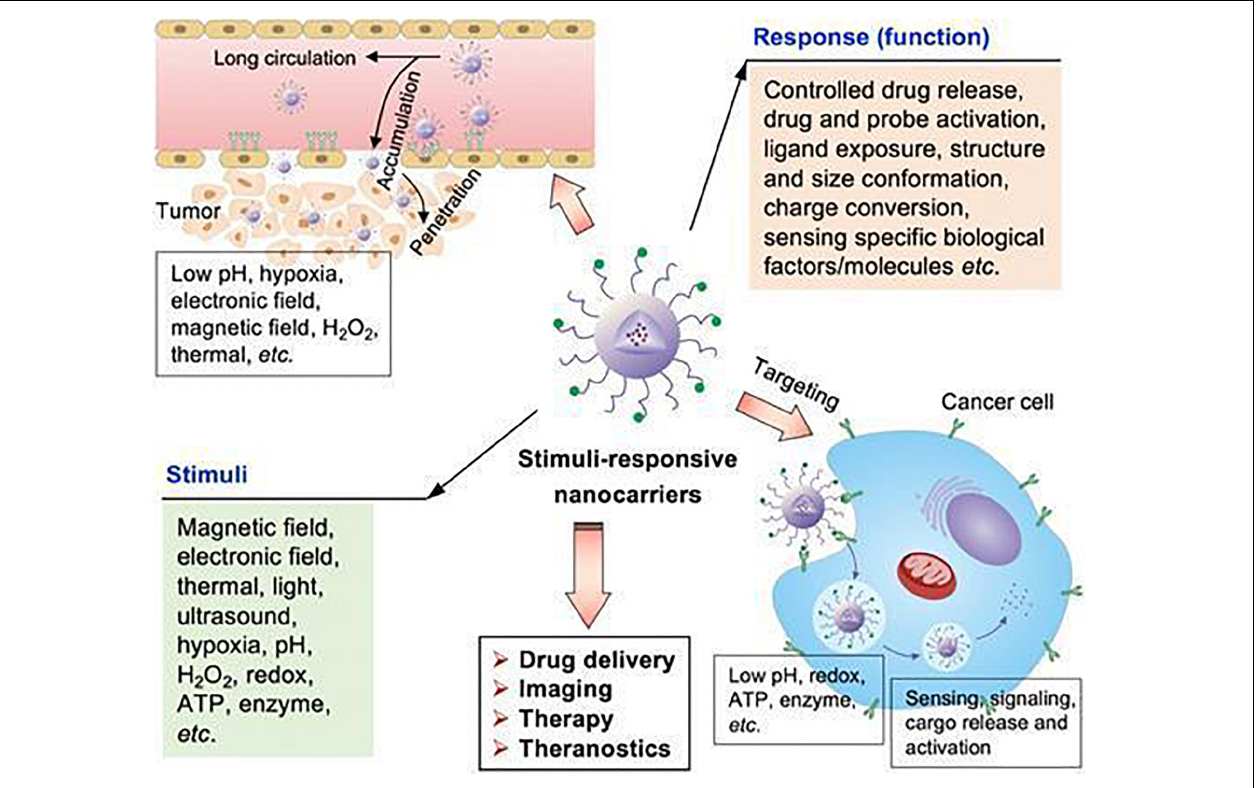
FIGURE 9 | The stimuli-sensitive functions of stimuli-responsive nanocarriers (Cairns et al., 2011). Nanoparticles can accumulate in tumor sites, responding to internal and external stimuli. Internal stimuli include: pH, redox, ATP, enzyme, and hypoxia etc., while external stimuli include electronic field, magnetic field, thermal, light and ultrasound. The stimuli-responsive characteristic promotes the release of drugs in tumor sites to achieve accurate diagnosis and treatment of tumors.